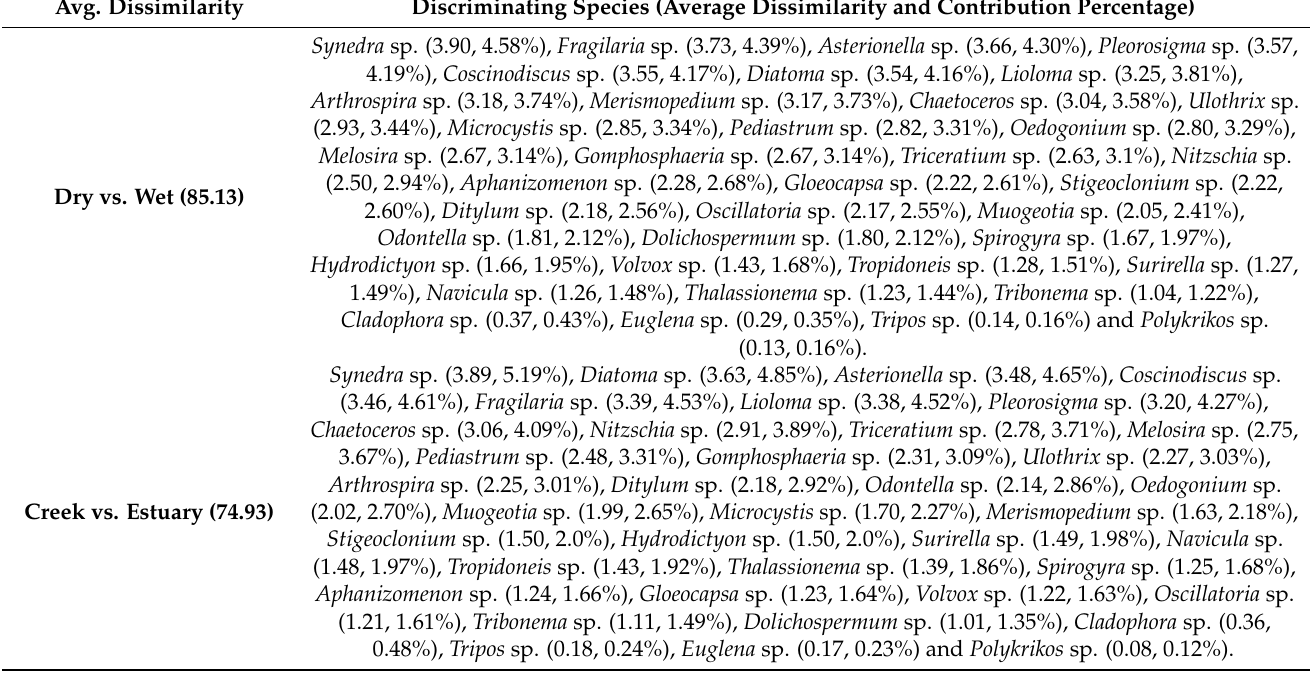
Table 6. SIMPER analysis depicted the ‘discriminating species’ that contribute to the maximum dissimilarity between the assemblages (sampling sites) and (seasons). Avg. Dissimilarity Discriminating Species (Average Dissimilarity and Contribution Percentage) Synedra sp. (3.90, 4.58%), Fragilaria sp. (3.73, 4.39%), Asterionella sp. (3.66, 4.30%), Pleorosigma sp. (3.57,